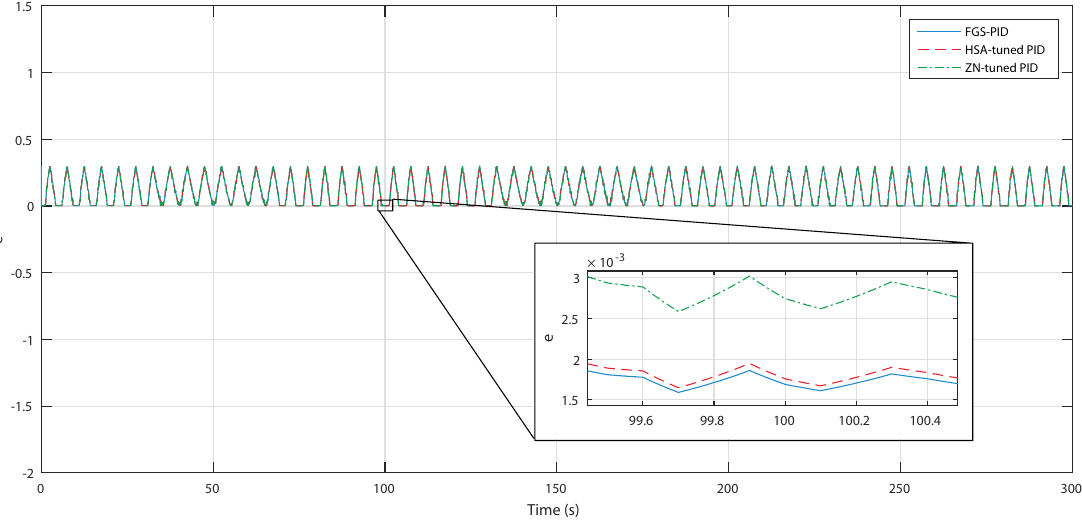
Figure 22. Error signal with different control methodologies in irregular